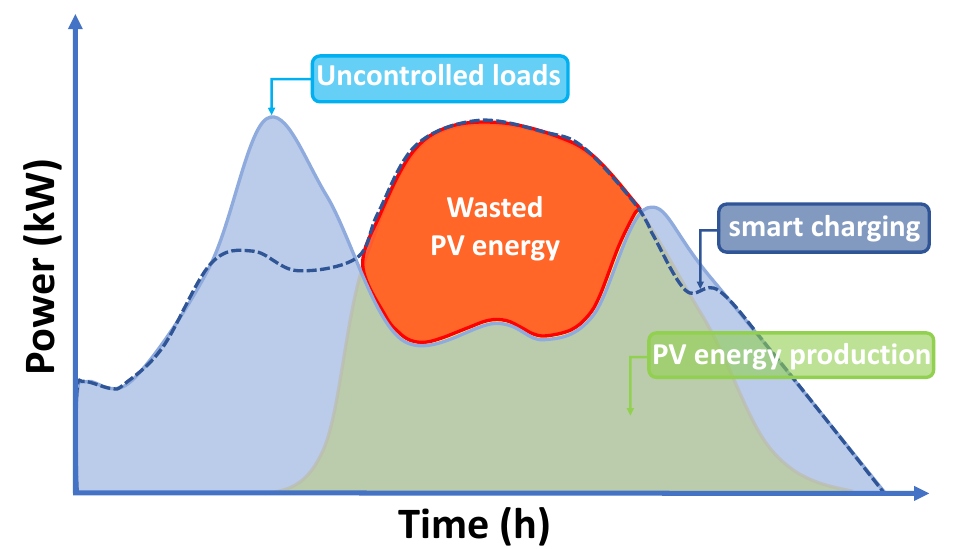
Figure 17. Consumption profile of EVs fleet during a working day with and without smart charging considering renewable energy